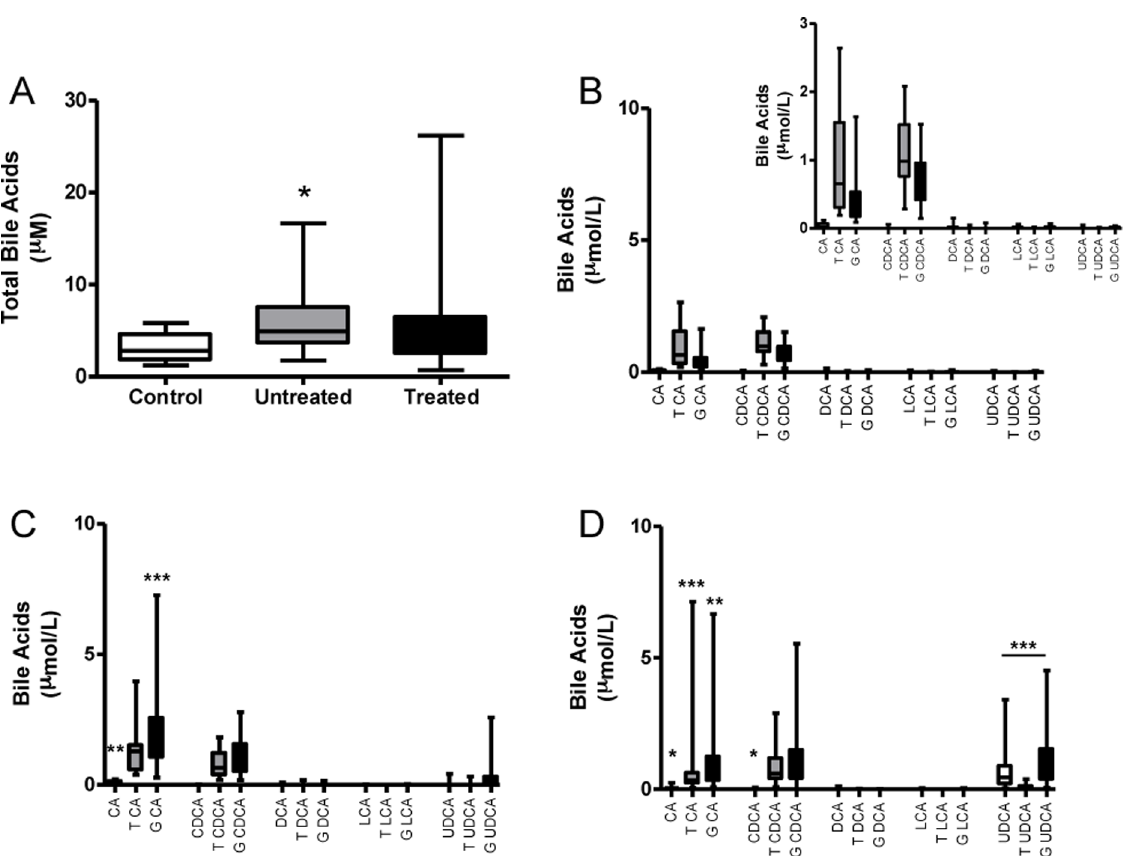
Figure 2. Total serum bile acids and HPLC-MS/MS analysis of bile acid profiles in umbilical cord serum. Total serum bile acids in control, untreated ICP and UDCA-treated ICP umbilical cord serum (A). Umbilical cord serum bile acid profiles in normal (B), untreated ICP (C) and UDCA- treated ICP pregnancies (D). In panels B–D, the serum bile acid level is shown using equivalent Y-axes in each group. However, given the significantly lower levels of bile acids in control serum the inset panel demonstrates these data using a smaller scale. * p= , 0.05, ** p= , 0.001, *** p= , 0.0001. Panel C comparisons vs. control, panel D comparisons vs. untreated ICP.